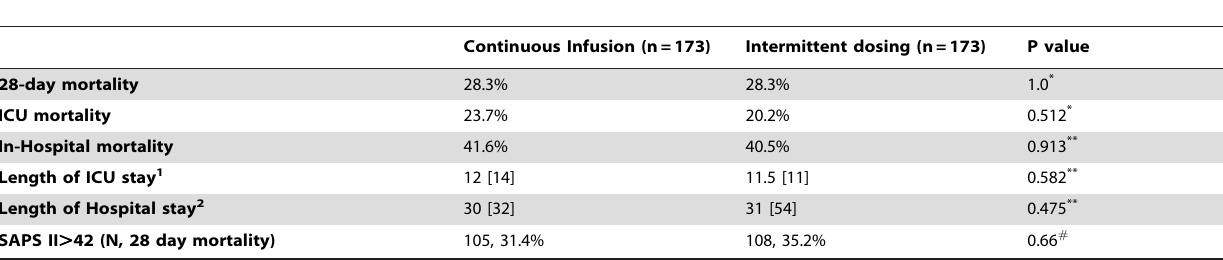
Table 3. Outcomes of patients treated with piperacillin/tazobactam, either as continuous infusion or intermittent